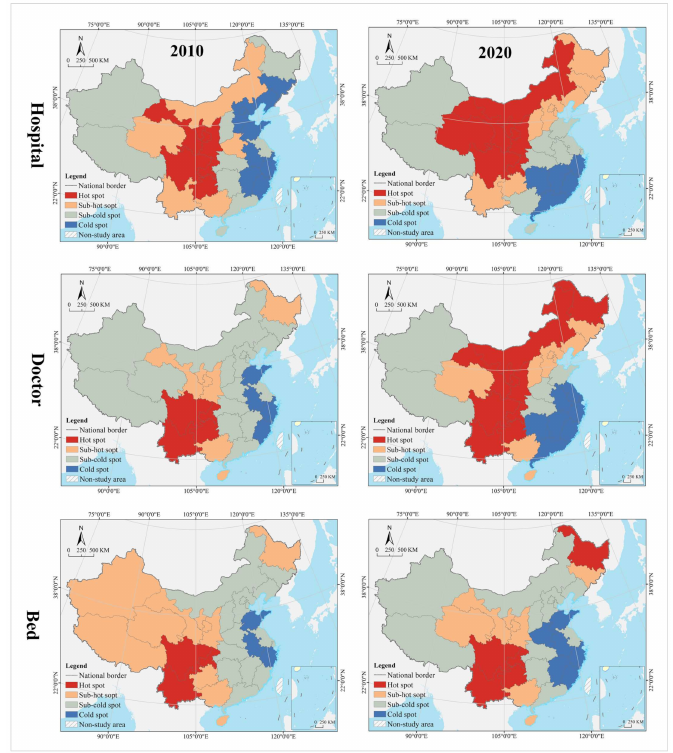
Figure 12. Spatial cold and hot spots analysis of mismatch type for supply.